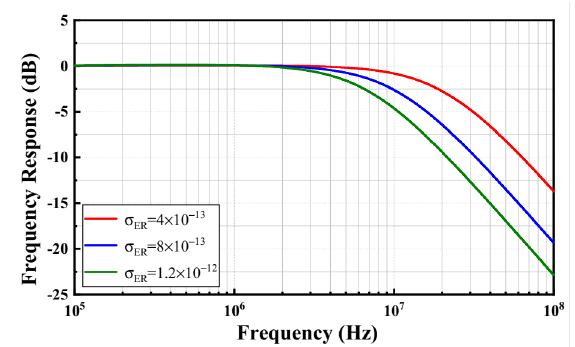
Figure 8. Jitter transfer of different input jitters.